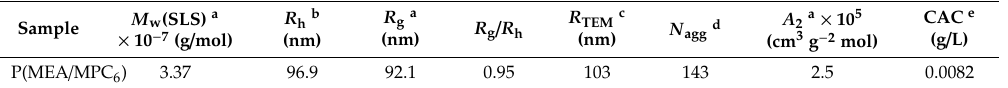
Table 2. The association behavior of P(MEA / MPC 6 ) in water.